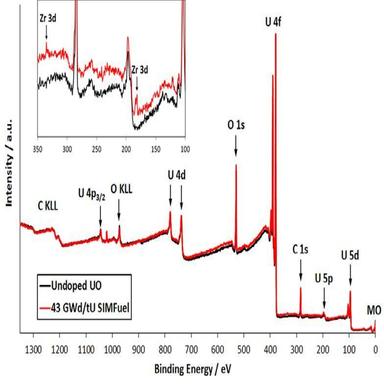
XPS survey scans of the Undoped UO2 and 43 GWd/tU SIMFuel samples. The inset shows a magnification of the binding energy range 100 – 350 eV.